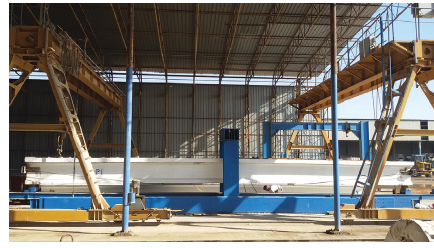
Figure 4: Testing